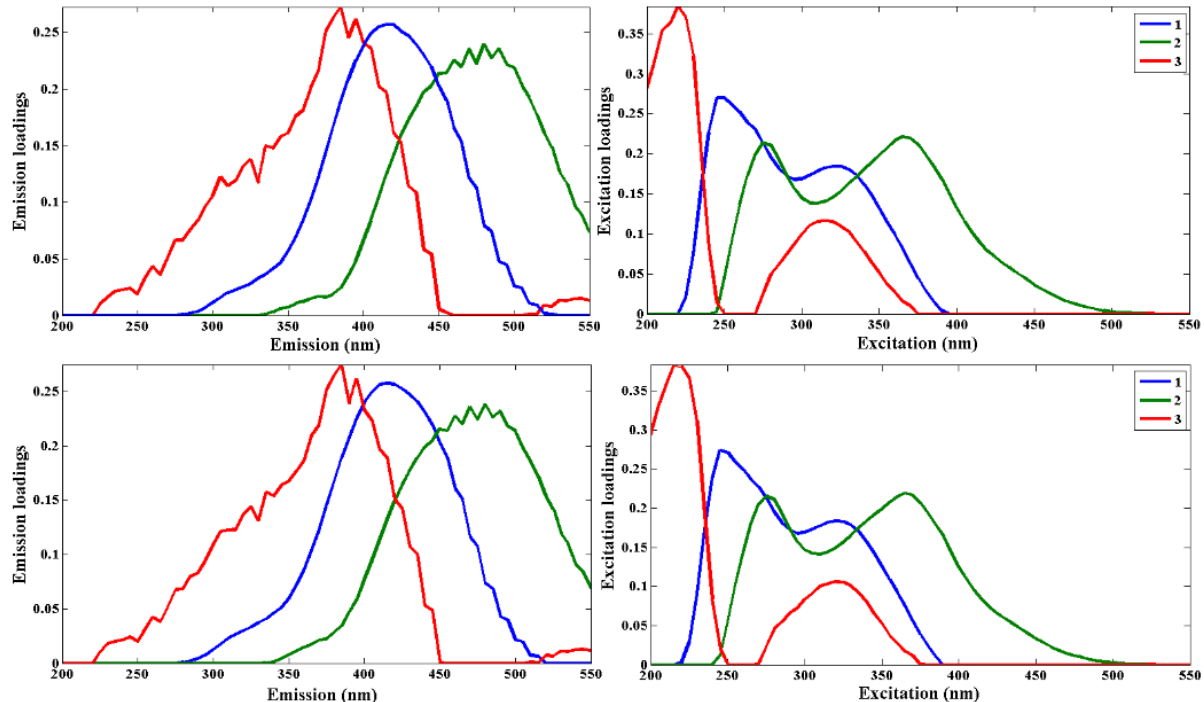
Figure 7. Split half validation of PARAFAC model B. When the fits of the splits are similar to each other and the entire model, a high stability of the model and low randomness of the fluorophores are